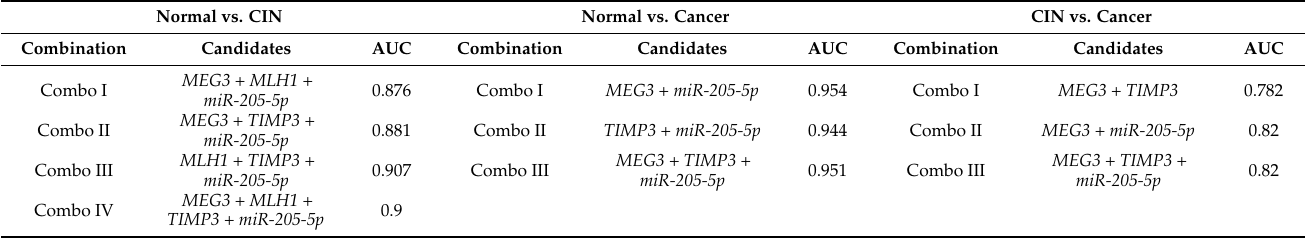
Table 1. The Area Under the Curve (AUC) values for the best predictive combinations. Normal vs. CIN Normal vs. Cancer CIN vs.